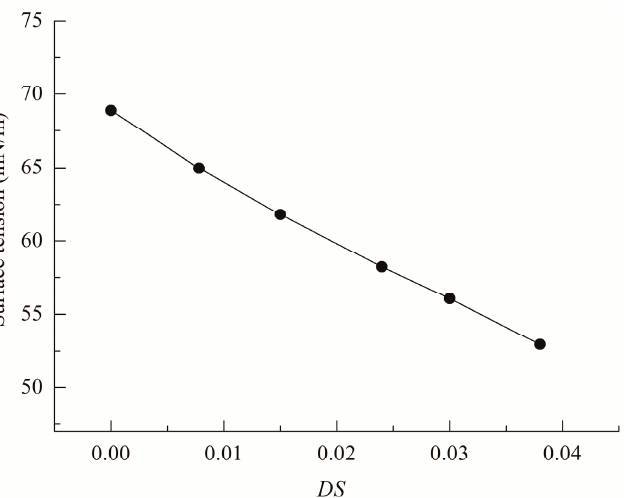
Figure 4. Influence of the sulfododecenylsuccinate substituents on the surface tension of starch